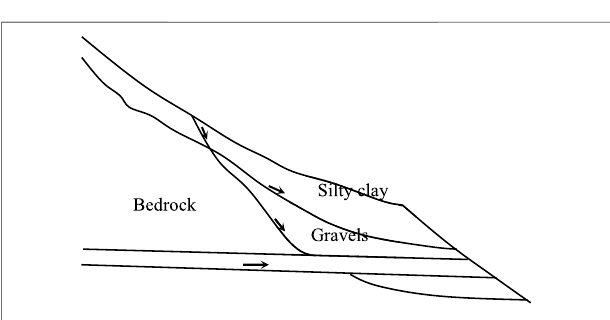
FIGURE3| LocationrelationshipbetweentherightentranceofYuantaizi tunnel and the landslide.